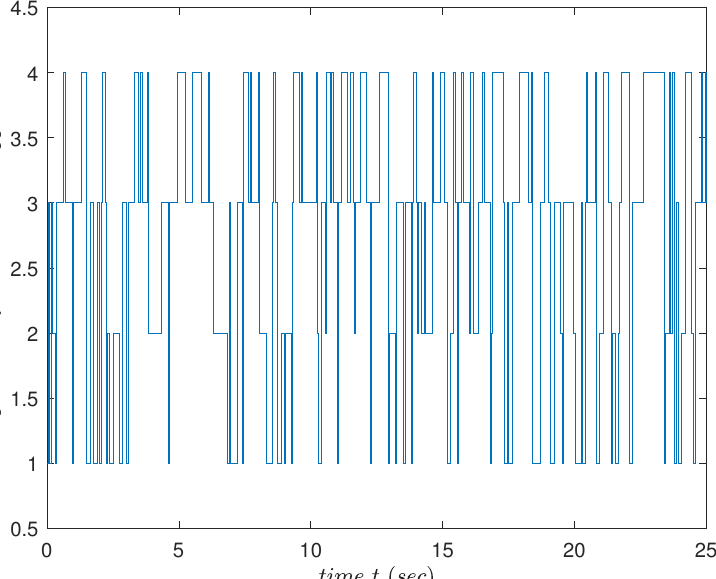
Figure 15. Different modes of the event-triggered scheme in Example 2, showing the modes and their durations of the triggering parameters at different